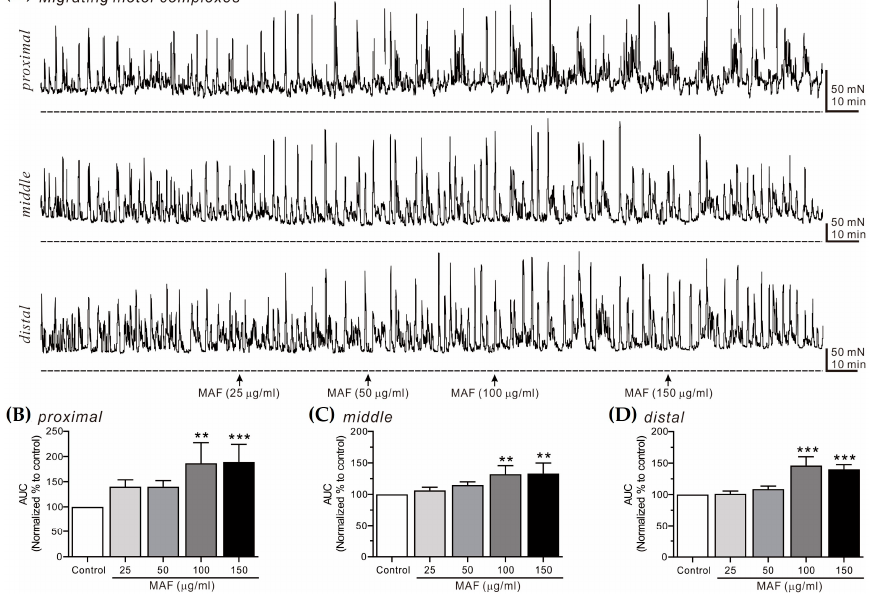
Figure 7. E ff ects of MAF on MMCs in human colonic segments in situ. ( A ) Representative raw traces showing that MAF increased MMCs in human sigmoid colon at the proximal, middle, and distal sites in a dose-dependent manner (25–150 µg/mL). Arrows indicate the points of MAF administration. Do tt ed lines indicate the baseline tension. ( B – D ) Summarized graphs showing the e ff ects of MAF on AUC at three different sites of the colonic segment. Significant difference (** p < 0.01 and *** p < 0.001) compared with